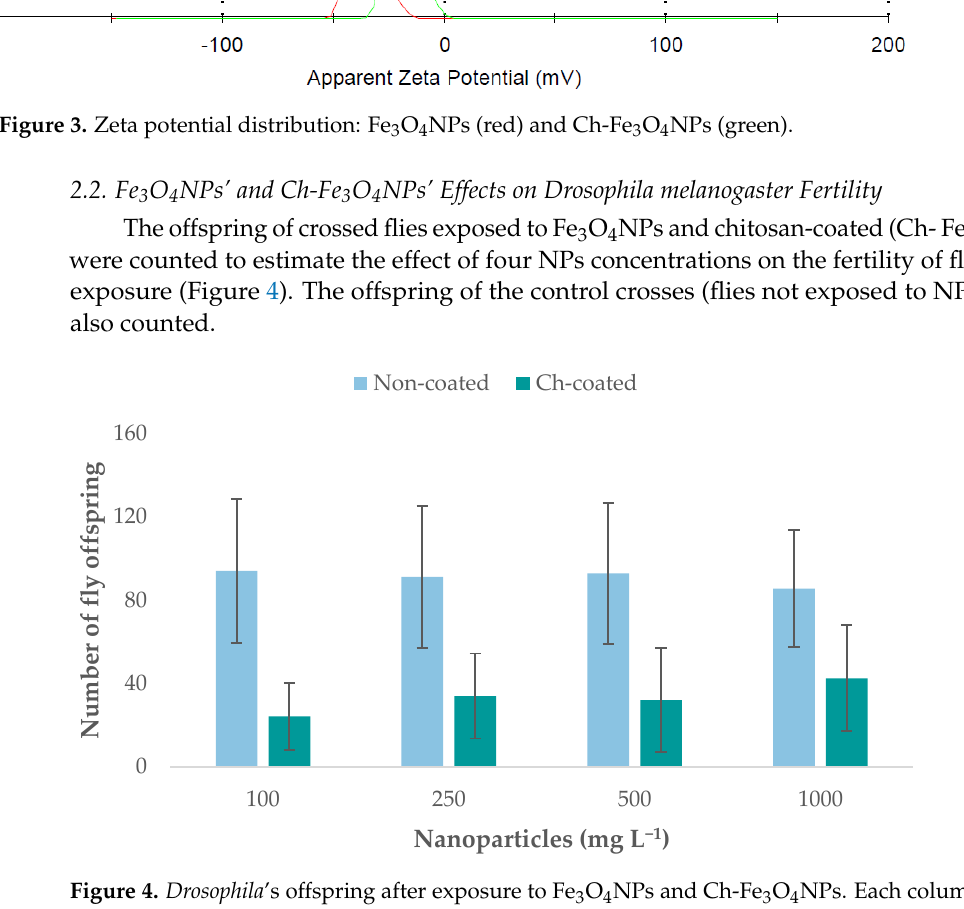
Figure 4. Drosophila ’s offspring after exposure to Fe 3 O 4 NPs and Ch-Fe 3 O 4 NPs. Each column shows the average number of adult flies that emerged in each tested concentration, along with the standard deviation ( n = 10).